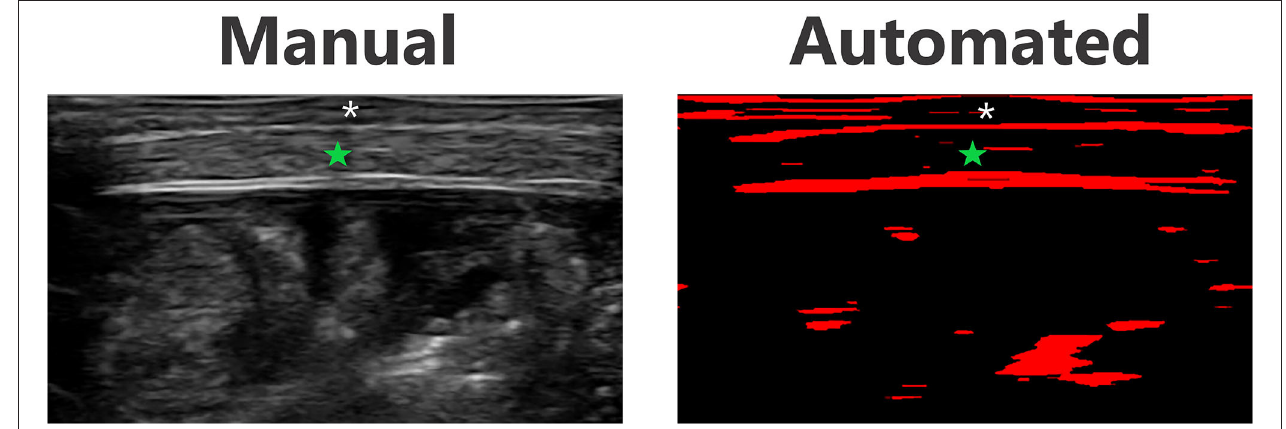
FIGURE 9 | Ultrasound and automated MuscleSound, Inc. software image example of the lateral abdomen in the same subject. Green star—muscle layer. Asterisk—subcutaneous tissue layer.